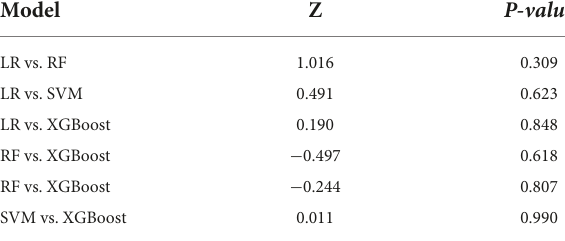
TABLE 6 De-long test, pairwise comparison between